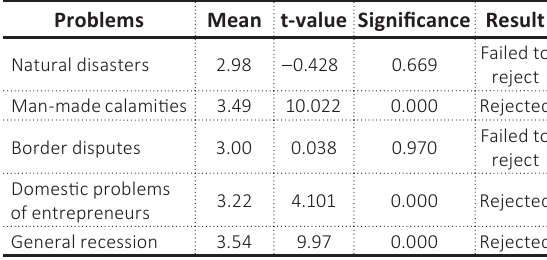
Table 14. Other related challenges